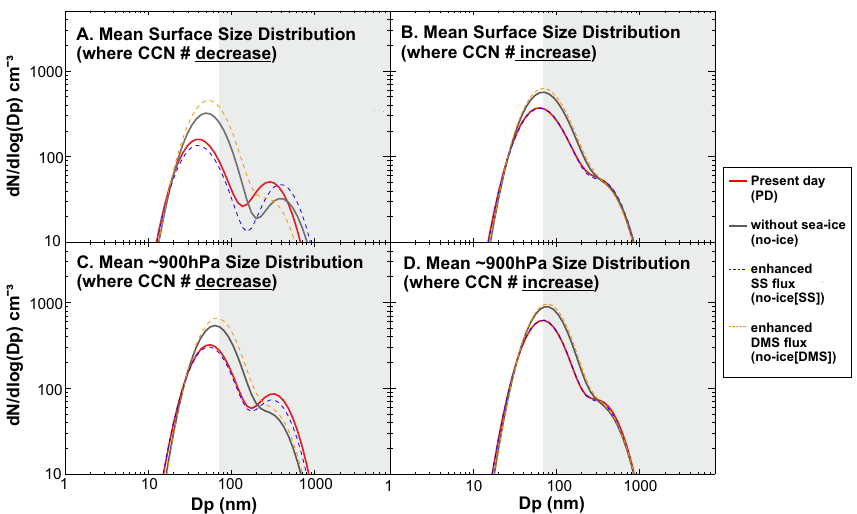
Figure 7. Average August size distribution for model grid boxes where CCN concentrations decrease in response to sea-ice loss (A, C) and Fig. 7. Average August size distribution for model grid-boxes where CCN concentrations decrease in increase in response to sea-ice loss (B, D) . Grid boxes included in the analysis are shown in Fig. 5. Analysis is shown for the surface (A, response to sea-ice loss (A,C) and increase in response to sea-ice loss (B,D). Grid-boxes included in the B) and the cloud level (C, D) for (in red) the present day (PD), (in grey) after sea-ice loss (no-ice), (in blue) with enhanced SS flux only (no-ice[SS]) and (in orange) with enhanced DMS flux only (no-ice[DMS]). analysis are shown in Fig. 5. Analysis is shown for the surface (A,B) and the cloud level (C,D) for (in red) the present day [PD], (in grey) after sea-ice loss [no-ice], (in blue) with enhanced SS flux only [no-ice[SS]] and (in orange) with enhanced DMS flux only [no-ice[DMS]].